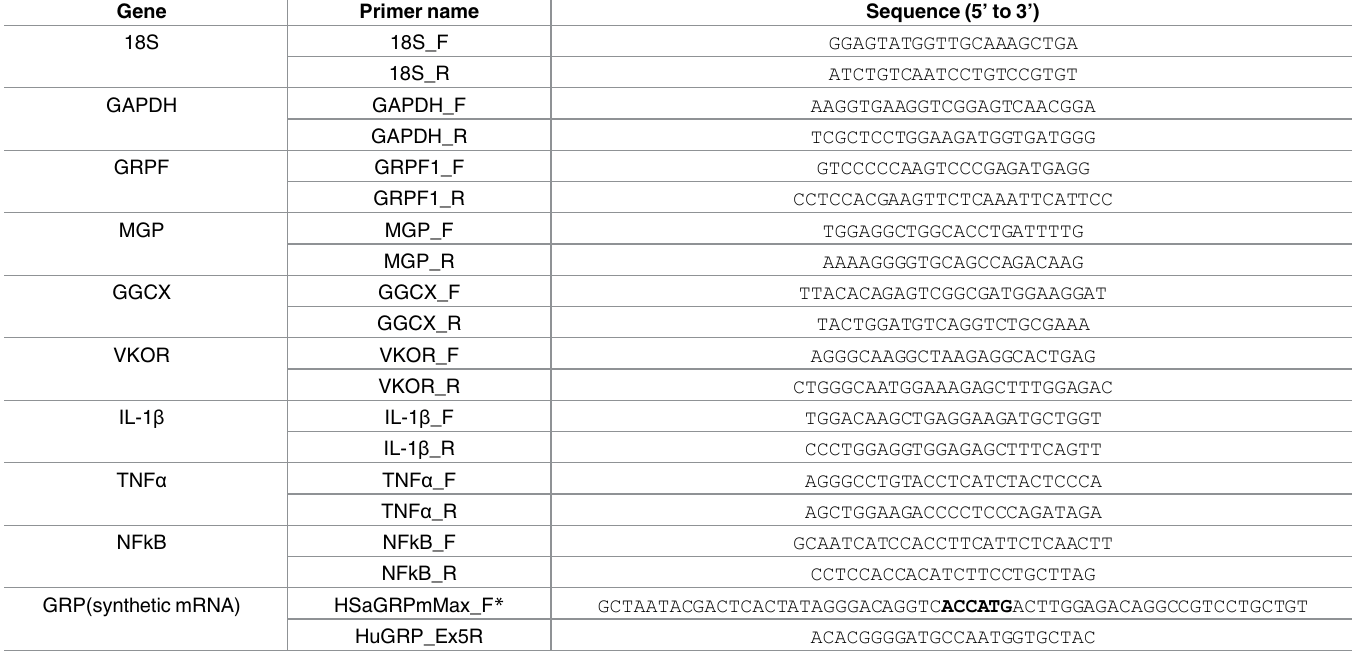
Table 1. Gene-specific primers used in this study.